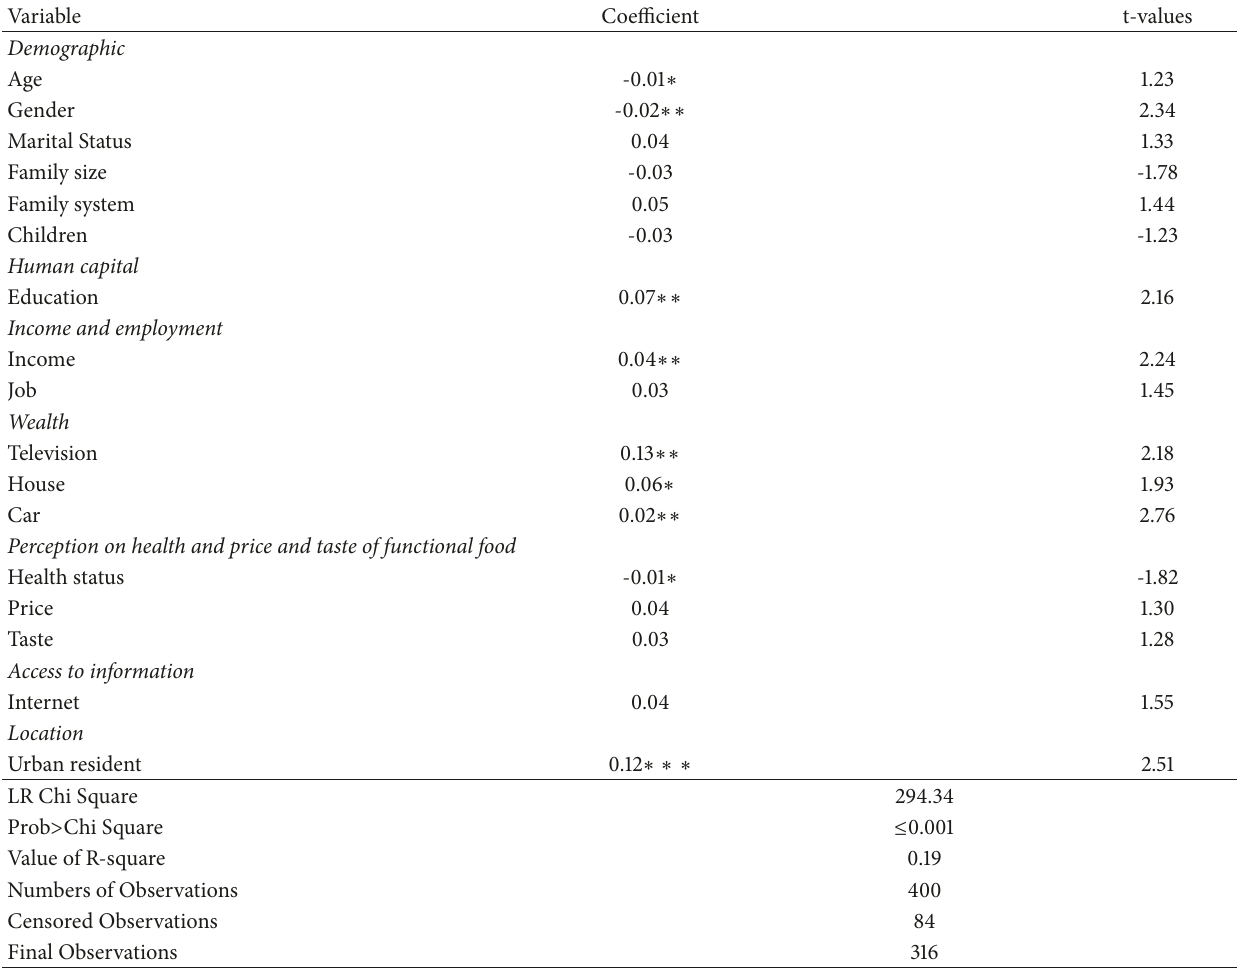
Table 7: Consumers’ willingness to pay for the functional foods (Tobit estimates).